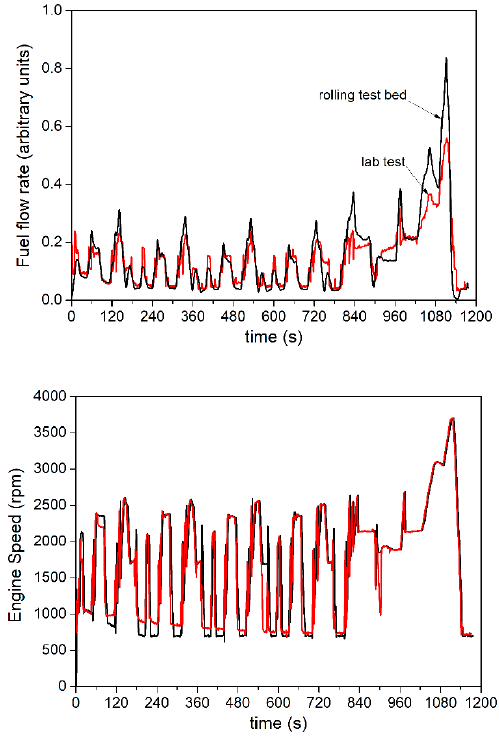
Figure 6. Comparison between the rolling test bed and stationary test rig fuel flow rate ( top ) and engine speed ( bottom ) for the 1.2 dm 3 engine.